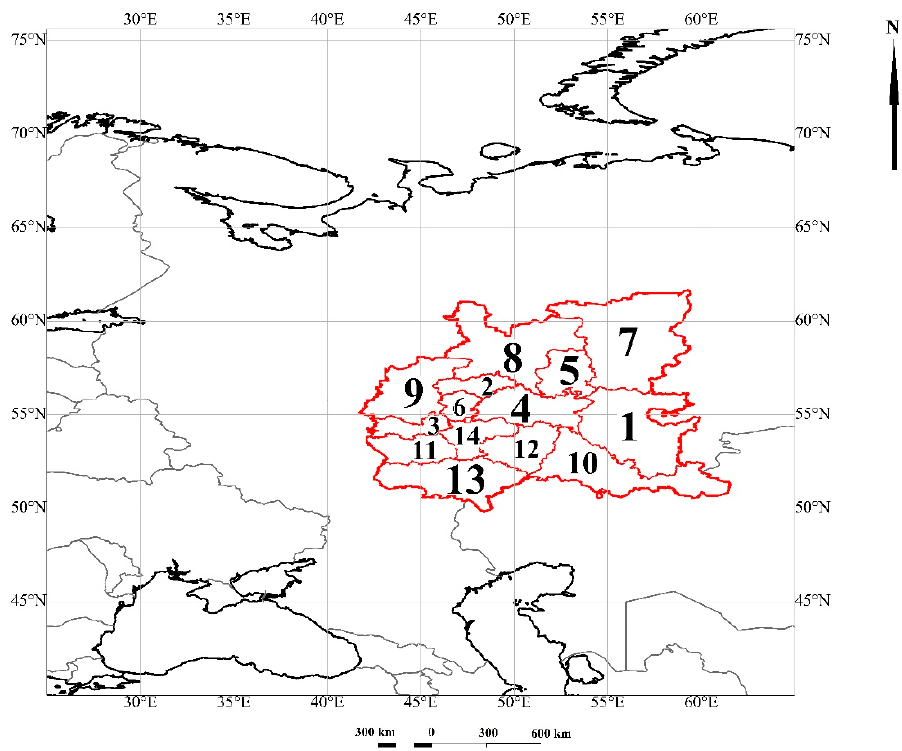
Figure 1. The administrative regions of the Volga Federal District (European Russia): 1—Republic of Bashkortostan; 2—Mari El Republic; 3—Republic of Mordovia; 4—Republic of Tatarstan; 5—Udmurt Republic; 6—Chuvash Republic; 7—Perm Region; 8—Kirov Region; 9—Nizhny Novgorod Region; 10—Orenburg Region; 11—Penza Region; 12—Samara Region; 13—Saratov Region; 14—Ulyanovsk Region.